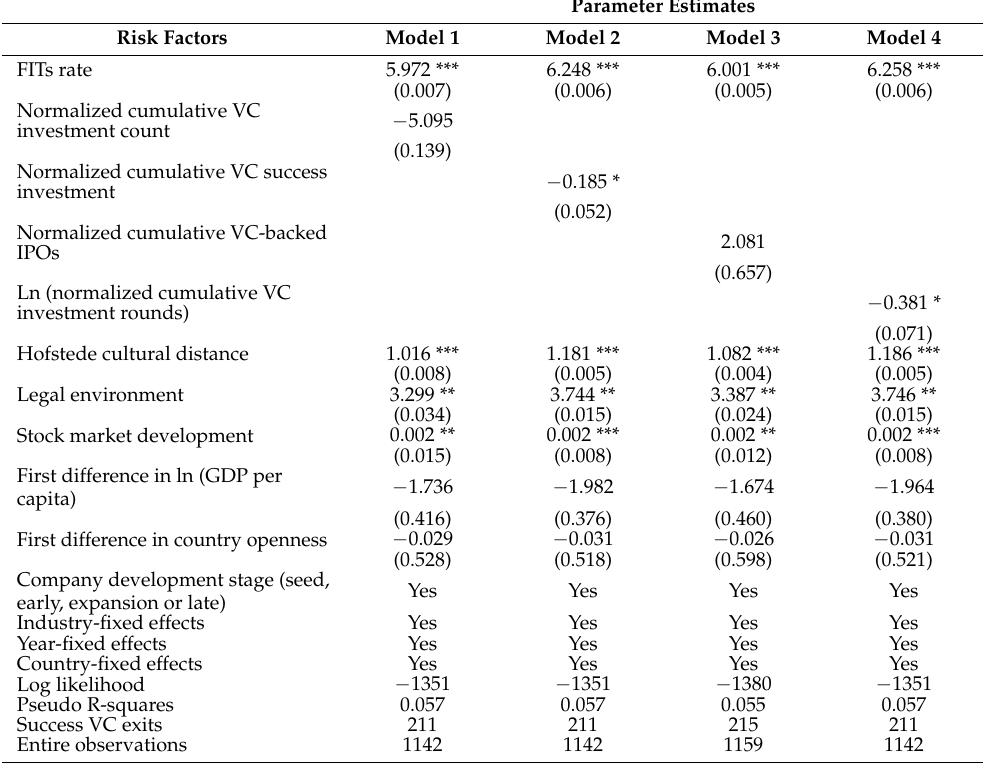
Table 7. Cox hazard analysis of 1159 VC-backed cleantech start-ups controlling for VC